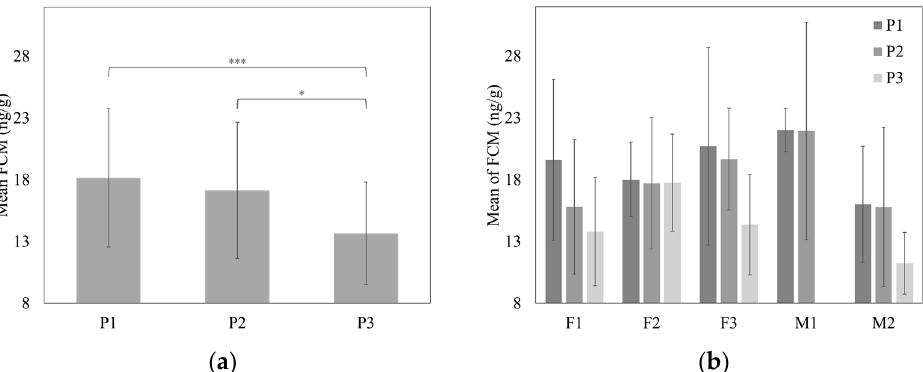
Figure 2. Plot of means ( ± SD) of fecal cortisol metabolite (FCM) concentrations before (P1 and P2) and after (P3) the death of the dominant male showing: ( a ) Group (F1, F2, F3, and M2) means; ( b ) individual means. Asterisk indicates * p < 0.05 and *** p < 0.001. Abbreviations: F1, female 1; F2, female 2; F3, female 3; M1, male 1; M2, male 2.